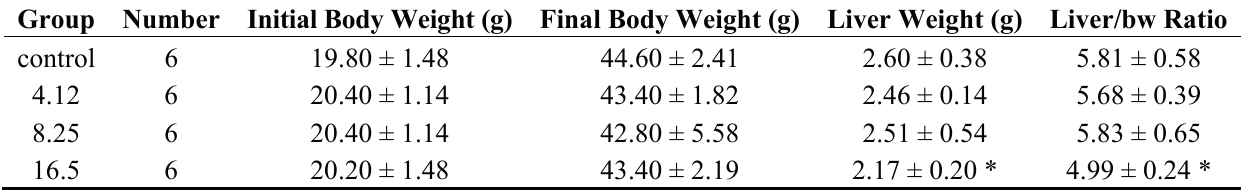
Table 2. Animal Weights and Liver/Body Weight (bw) Ratio (final) of mice after 28 days intravenous treatment with CdTe QDs